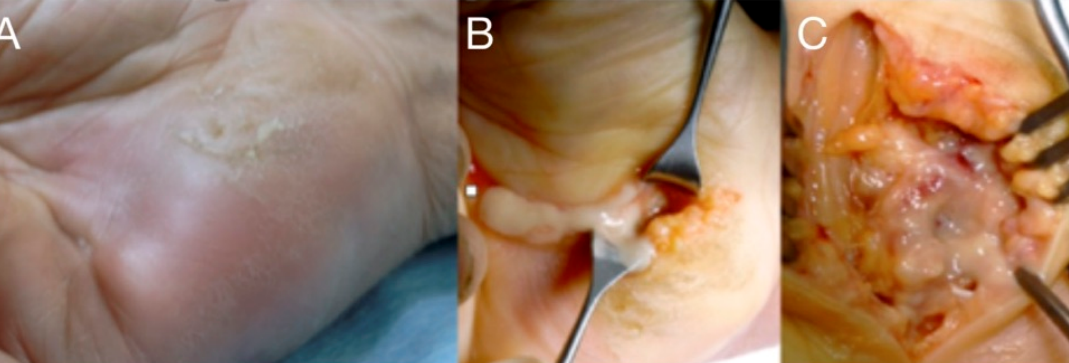
Figure 3. A neglected puncture wound at the ulnar side of the palm led to abscess formation into the hypo-thenar ( A ). Treatment included drainage, irrigation ( B ), and careful debridement protecting the ulnar neuromuscular bundle ( C ).